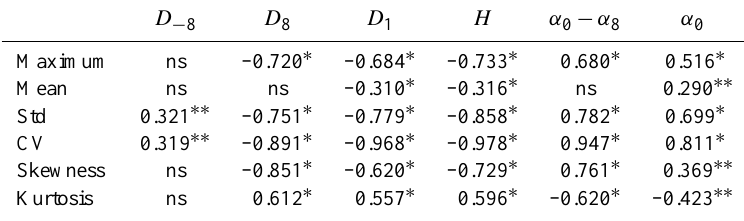
Table 3. Correlation between selected statistical and multifractal